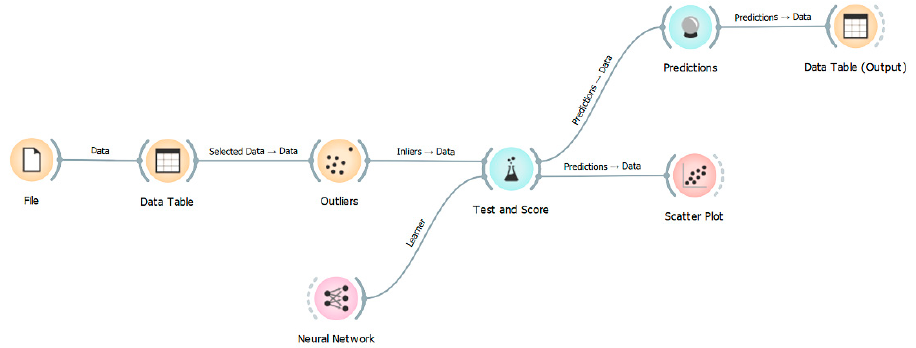
Figure 6. Simulated workflow of the model in Orange 3 data-mining software.